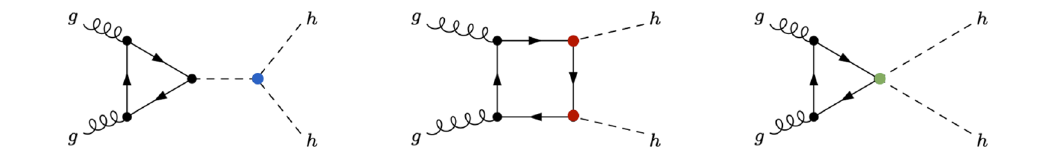
Figure 12 . Diagrams contributing to Higgs pair production in the EFT approach (with c g = c gg = 0 and neglecting the chromomagnetic operator). The blue, red and green blobs denote the